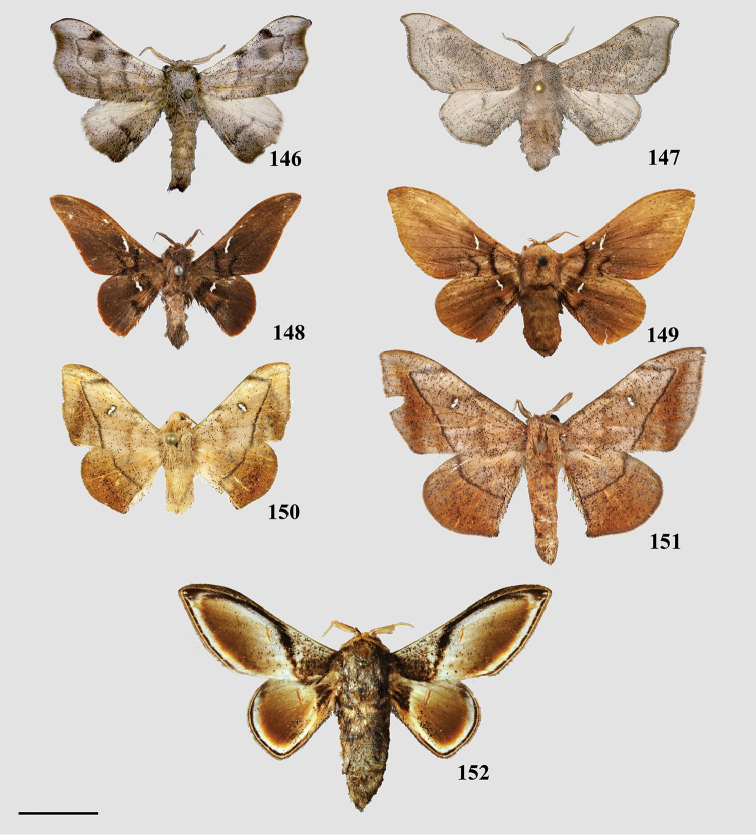
Adult specimens of type species of genera belonging to Cicinninae: Cicinnini. 146Aceclostriamus, male [photo S Naumann] (ZSM) 147A.cfmus, female [photo C Mielke] (CGCM) 148Aleydaaccipiter, male [reused with permission from St Laurent et al. (2018a), SHILAP] (NHRS) 149A.accipiter, female [reused with permission from St Laurent et al. (2018b), SHILAP] (CUIC) 150Arcinnuscfhoedli, male (MWM) 151A.hoedli, female [photo R Lahousse] (MNHN) 152Euphanetadivisa, male (MGCL). Scale bar: 1 cm.